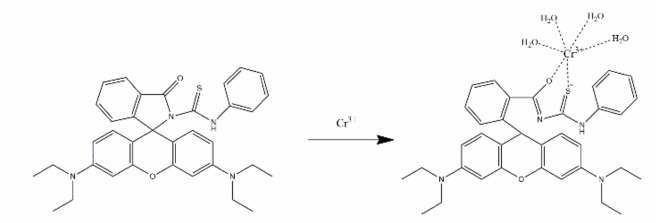
Figure 34. The possible binding mechanism of RB-CR (Table 1, No. 44) to Cr 3+ [69]. A rhodamine-based sensor (Rh-Hyd) was reported by Rathinam B., et al. (Table 1, No. 45) [70]. The carbonyl and terminal amino groups of Rh-Hyd showed high affinity to Sn 2+ . The presence of Sn 2+ induced spirolactam ring-opening reaction of Rh-Hyd and then changed the color and fluorescence of the prepared sensor. The proposed sensing mechanism of Rh-Hyd to Sn 2+ was shown in Figure